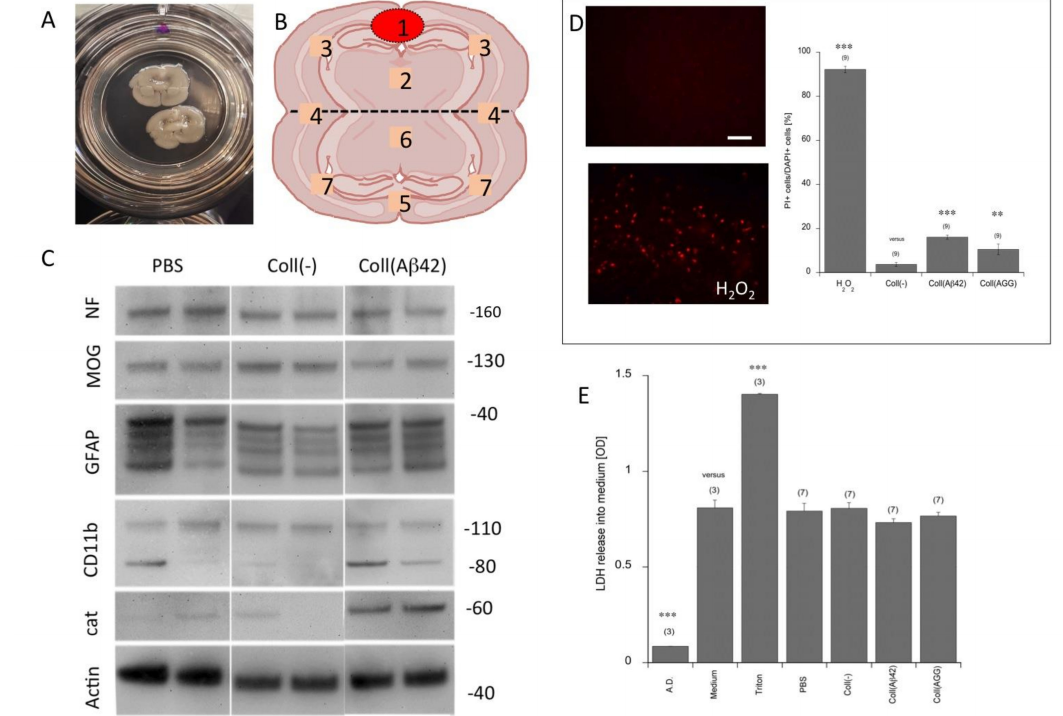
Figure 1. Scheme of the organotypic brains slices and viability. Coronal organotypic brain slices were prepared from postnatal day 8–10 mice and placed on 0.4 µ m semipermeable membrane inserts ( A ). ( B ) The schematic connection of an upper “donor slice” and a lower “target slice”. The red circle shows placement of the collagen hydrogel loaded with beta-amyloid peptides. The values 1–7 give the areas which were analyzed. Western blot analysis (from two independent mice) showed a stable expression of neurofilament (NF), myelin oligodendrocyte protein (MOG) and glial fibrillary acidic protein (GFAP) ( C ). Microglial CD11b was weakly expressed in all slices, with a somewhat higher density in slices where the beta-amyloid was applied, but showed a high heterogeneity between slices ( C ). Catalase was very weak, but markedly increased in slices where beta-amyloid was applied ( C ). Actin served as a loading control. Propidiumiodide (PI) staining showed a weak background in all slices, and no marked changes between the groups. As a positive control for the assay, slices were incubated with H 2 O 2 for three days ( D ). Lactate dehydrogenase (LDH) release into medium showed no marked changes between the groups, while the positive control (2% Triton) markedly increased LDH release into medium after one day ( E ). Values are given as means ± SEM; values in parenthesis give the number of analyzed animals. Statistical analysis was performed using ANOVA with a Fisher LSD post hoc test, where p < 0.05 represents significance versus a control (** p < 0.01, *** p < 0.001; n.s., not significant). Scale bar in D = 450 µ m ( A ), 60 µ m ( D ). PBS, phosphate buffered saline; Coll(–), empty collagen hydrogel, A β , beta-amyloid; AGG, aggregated, A.D., aqua